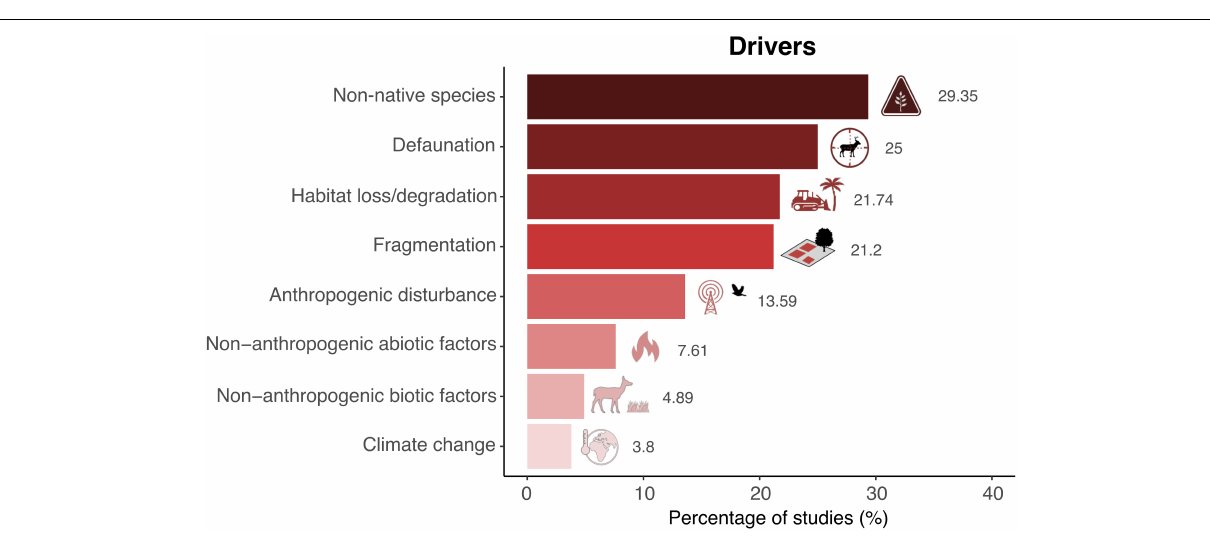
FIGURE 2 | Main causes of seed dispersal disruptions. Shown are the percentages of studies reporting each anthropogenic or non-anthropogenic impact as a driver of SDD. Note that the total sum of percentages exceeds 100% because some studies reported more than one driver ( N = 237 records identified in the 184 original